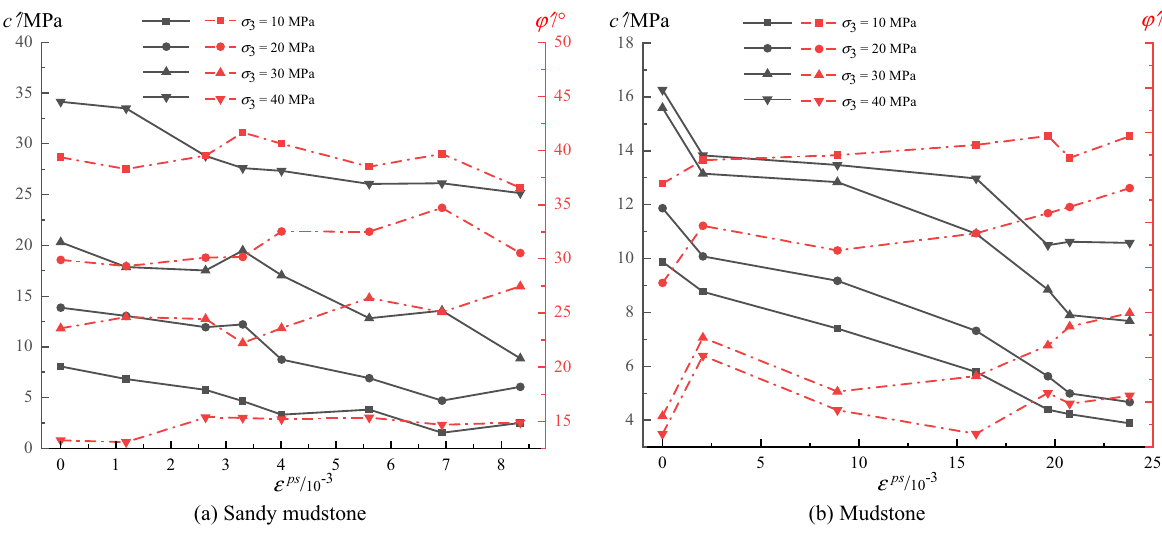
Fig. 11 Curves of the relationship between c ′ , φ ′ , and ε ps under different confining